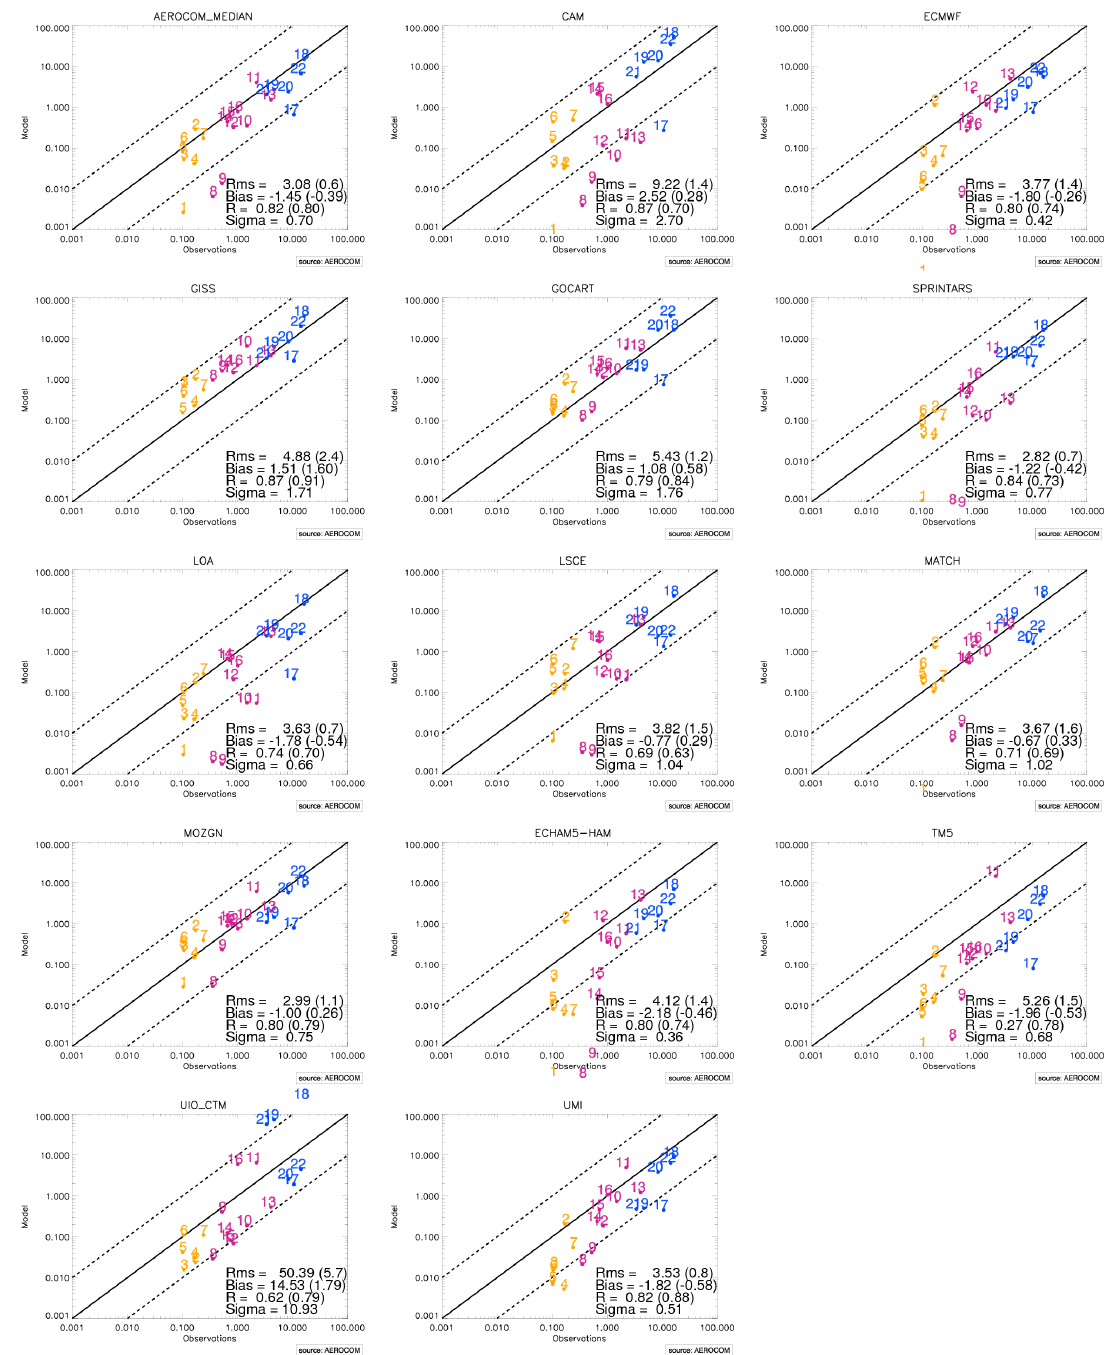
Fig. 5. Yearly averaged measured surface concentration from the network operated by the University of Miami versus modeled one at each station, units are µgm − 3 . Stations are grouped according to the regime of measured data into remote stations (orange), stations under the influence of minor dust sources of the Southern Hemisphere or remote sites in the Northern Hemisphere (violet) and locations downwind of African and Asian dust source (blue). The location of each station is illustrated in Fig. 2 and given in Table S2 in the Supplement. Root mean square error (RMS), bias, ratio of modeled and observed standard deviation (sigma) and correlation ( R ) are indicated for each model in the lower right part of the scatter plot. Mean normalized bias and normalized root mean square error are given in parenthesis next to RMS and mean bias, respectively. The correlation with respect to the logarithm of the model and of the observation is also given in parenthesis next to R . Black continuous line is the 1:1 line whereas the black dotted lines correspond to the 10:1 and 1:10